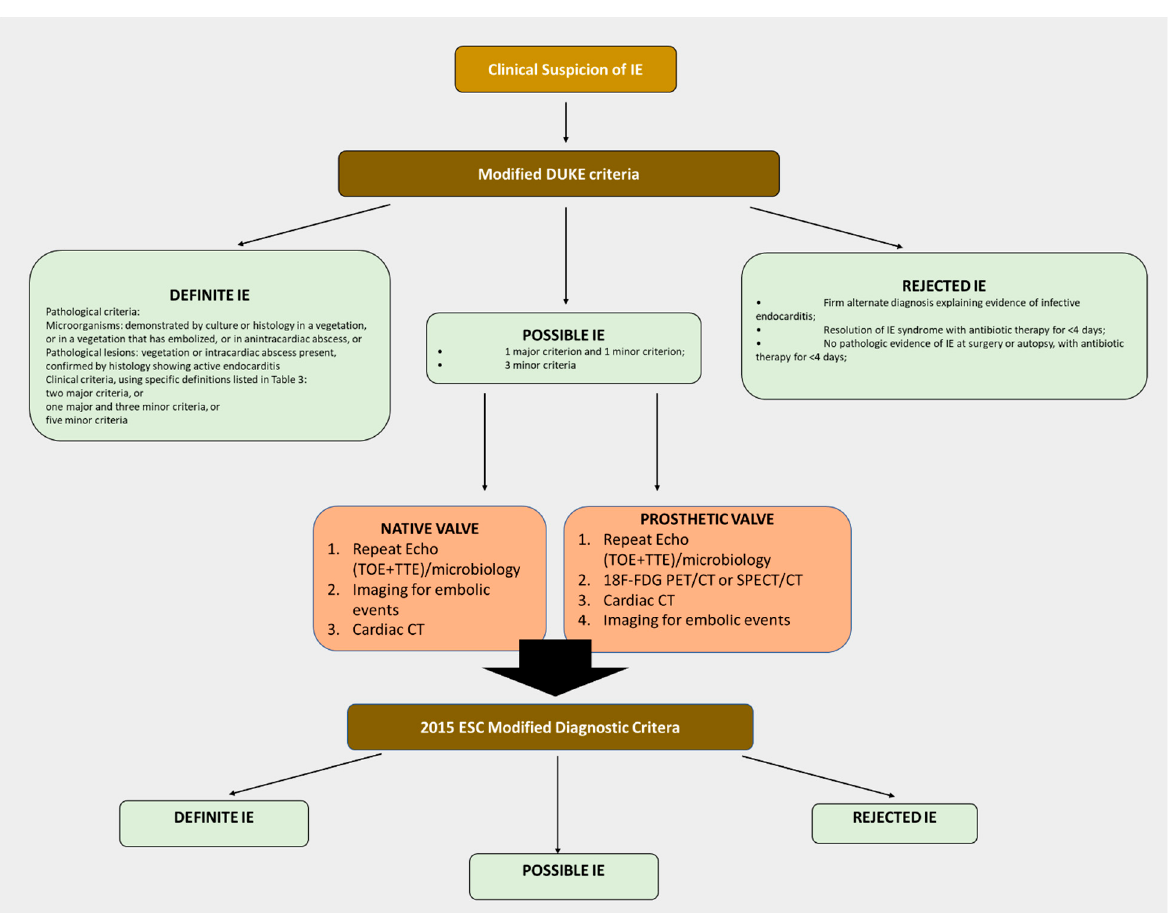
Figure 1. 2105 ESC guidelines—Diagnostic Algorithm.